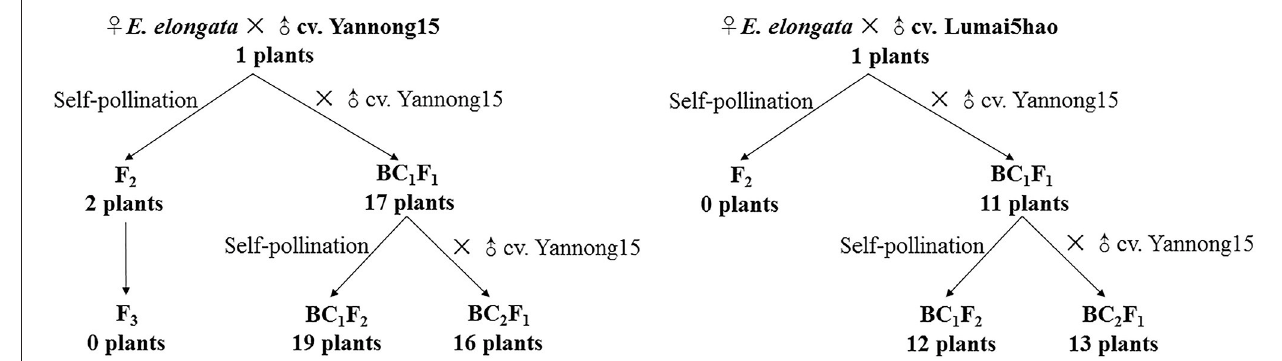
FIGURE 1 | Scheme of crosses between E. elongata × T.